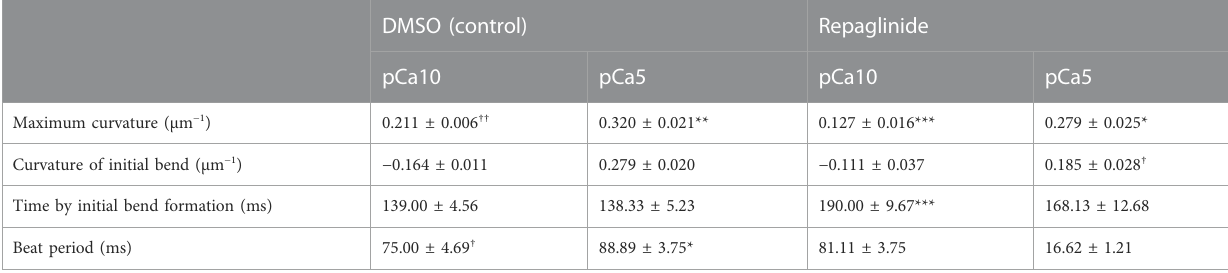
TABLE 1 Properties of fl agellar bends generated by the photolysis of caged ATP.